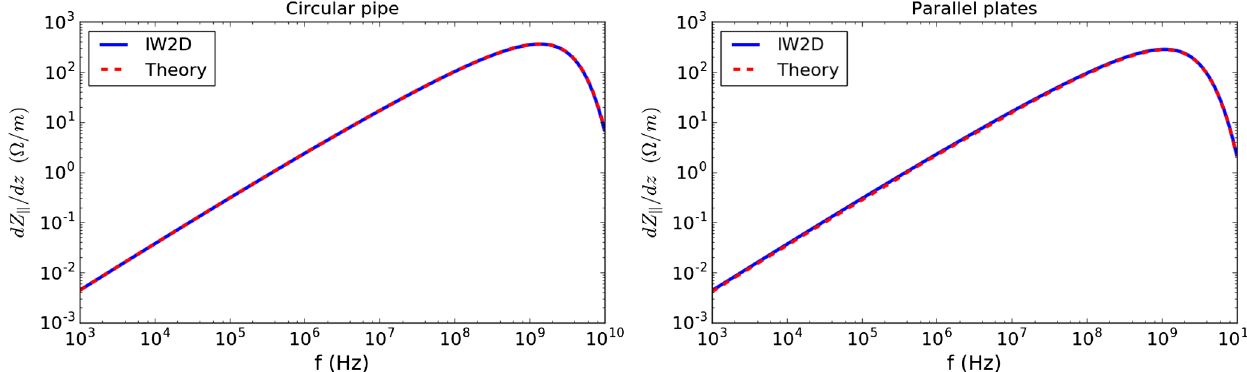
FIG. 6. Longitudinal indirect space charge per unit of length for b ¼ 3 . 5 cm and β ¼ 0 . 9 as a function of frequency. Comparison between IW2D and Eq. (38) for circular pipe (left) and parallel plates